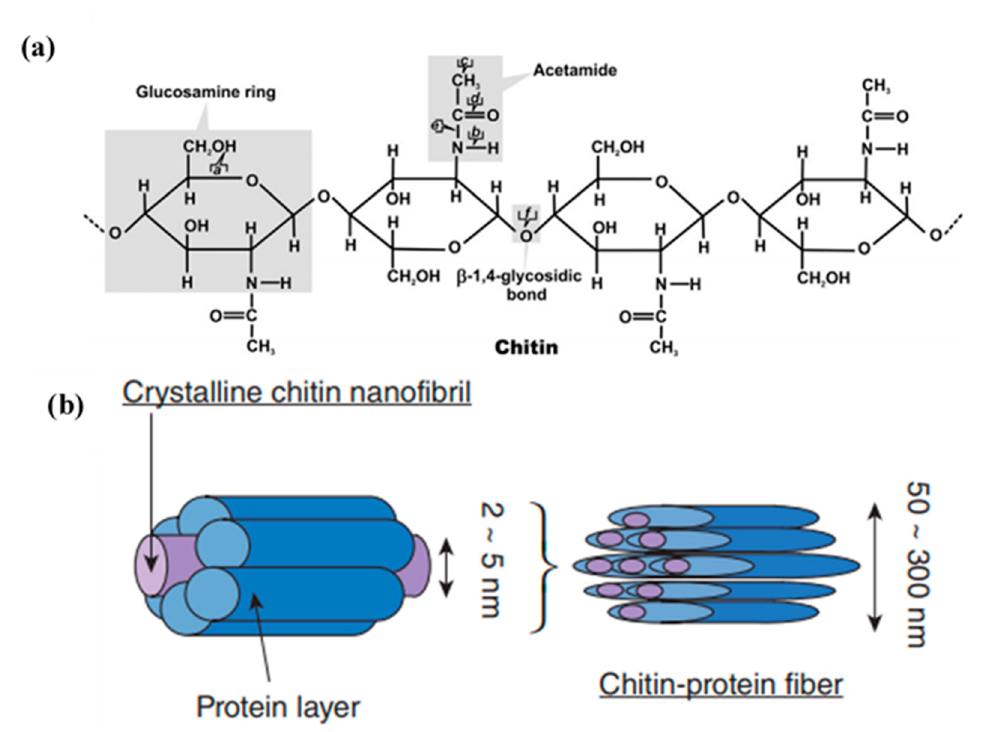
Figure 1. ( a ) Chemical structure of chitin [4]. ( b ) Representation of native chitin nanofibrils in crustacean shells [5].